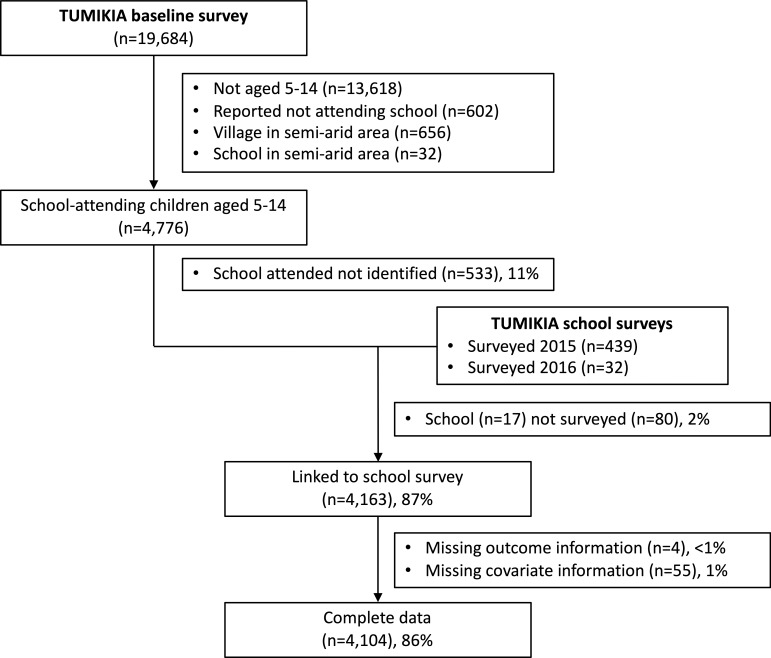
Flow chart of participants in the TUMIKIA baseline survey who were included in the current analysis.Eligible sample included children aged 5–14 years who reported attending school and not residing in villages or attending schools in semi-arid areas. The proportion of eligible subjects with complete data is 86% (4,104/4,776).